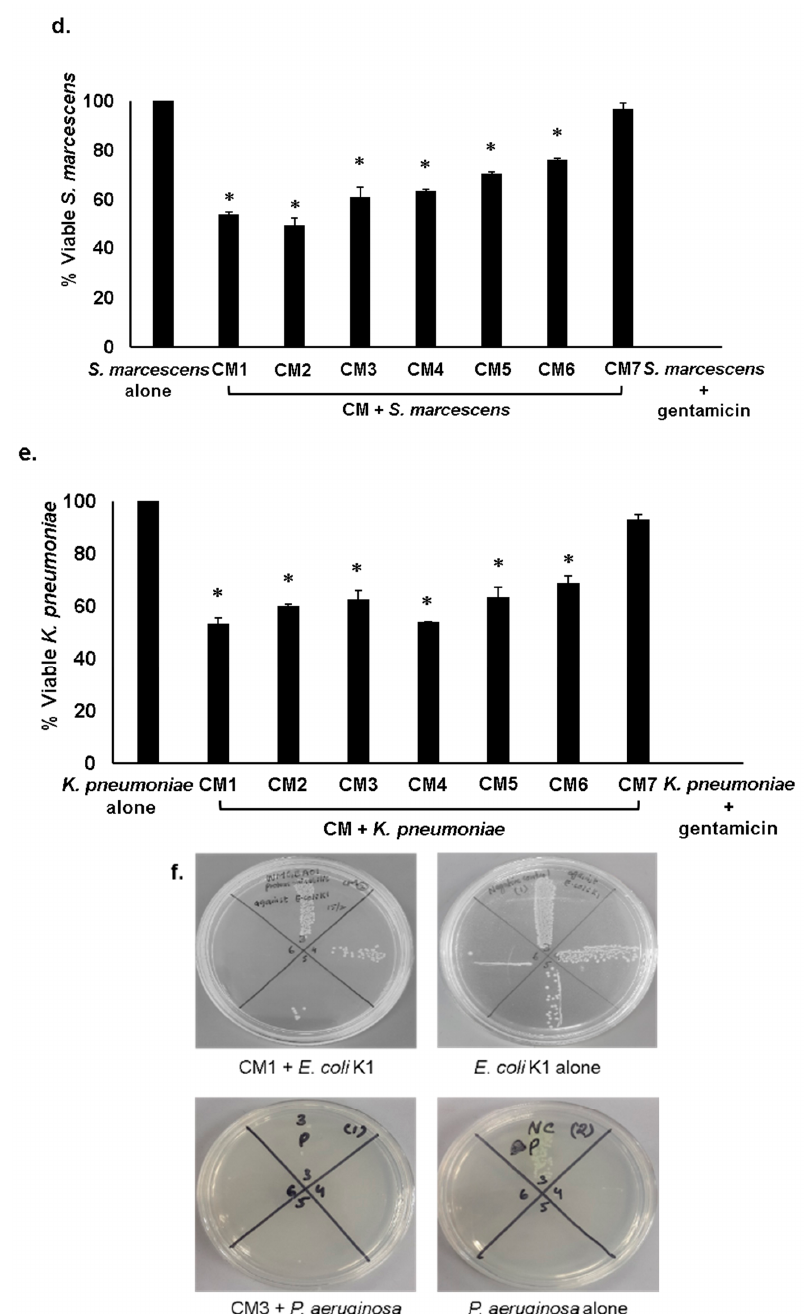
Figure 2. Conditioned medium (CM) from water monitor lizard (WML) gut bacteria exhibited significant bactericidal activities against selected Gram-negative pathogenic bacteria. Briefly, 1 × 10 6 bacteria were mixed with CM from WML gut bacteria and culture was incubated at 37 ◦ C for 2 h. Next, the culture was serially diluted and plated on nutrient agar plates. Plates were incubated at 37 ◦ C for 24 h and bacterial colonies were enumerated. The data is expressed as the mean ± standard error of several independent experiments performed in duplicate. P Values were determined using student’s T-test, two-tailed distribution, (*) is P ≤ 0.05. Bacteria incubated with PBS and gentamicin (100 µ g / mL) were taken as negative and positive controls. ( a ) CM tested against E. coli K1, ( b ) against P. aeruginosa ( c ) against S. enterica ( d ) against S. marcescens , ( e ) against K. pneumoniae and ( f ) representative e ff ects of CM against E. coli K1 and P. aeruginosa . CM1 is P. mirabilis , CM2 is A. hydrophila , CM3 is C. freundii, CM4 is E. coli , CM5 is Staphylococcus sp., CM6 is S. aureus and CM7 is E. coli